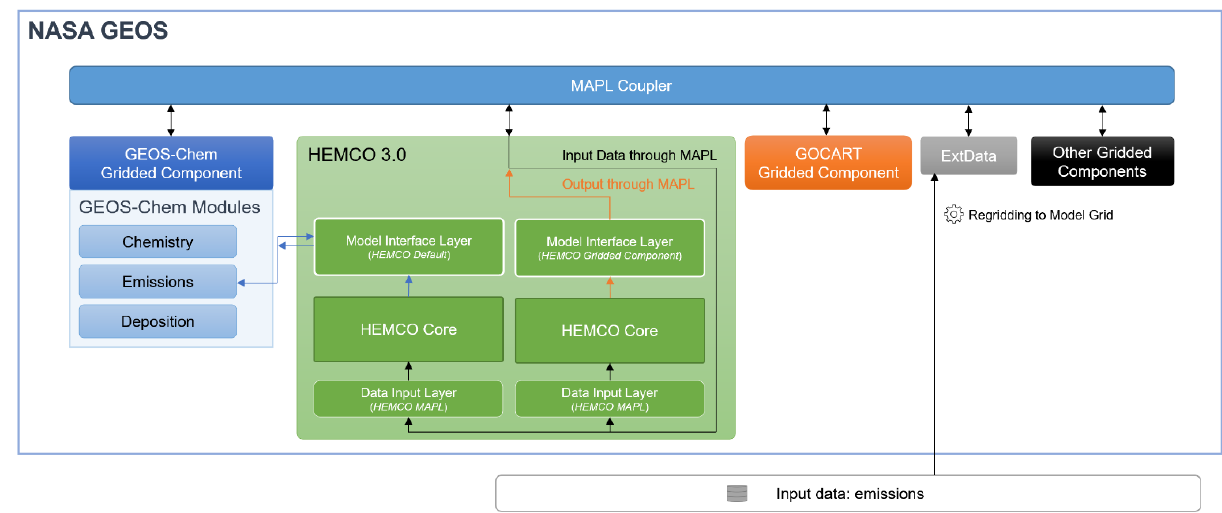
Figure 6. HEMCO 3.0 implementation in the NASA GEOS Earth System Model. GEOS is driven by the MAPL framework in an MPI parallel environment and is composed of a number of gridded components for the different ESM operators. GOCART provides a fast aerosol simulation and GEOS-Chem provides detailed chemistry. HEMCO serves both GOCART and GEOS-Chem. The ExtData component reads all data into MAPL, re-gridding them to the model grid, and the input data are retrieved by the HEMCO MAPL implementation of the Data Input Layer. GEOS-Chem and GOCART each have their own HEMCO instances. After emissions are processed by the HEMCO Core, they are exported to GEOS-Chem through the HEMCO default Model Interface Layer and to the GOCART gridded component through a HEMCO gridded component model interface